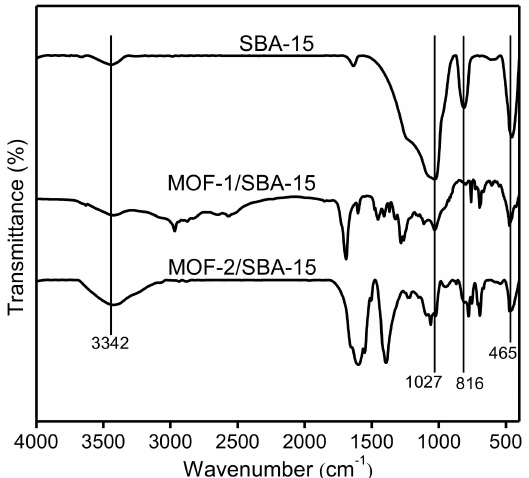
Figure 4. FT-IR spectra of spherical SBA-15, MOF-1/SBA-15 and MOF-2/SBA-15.